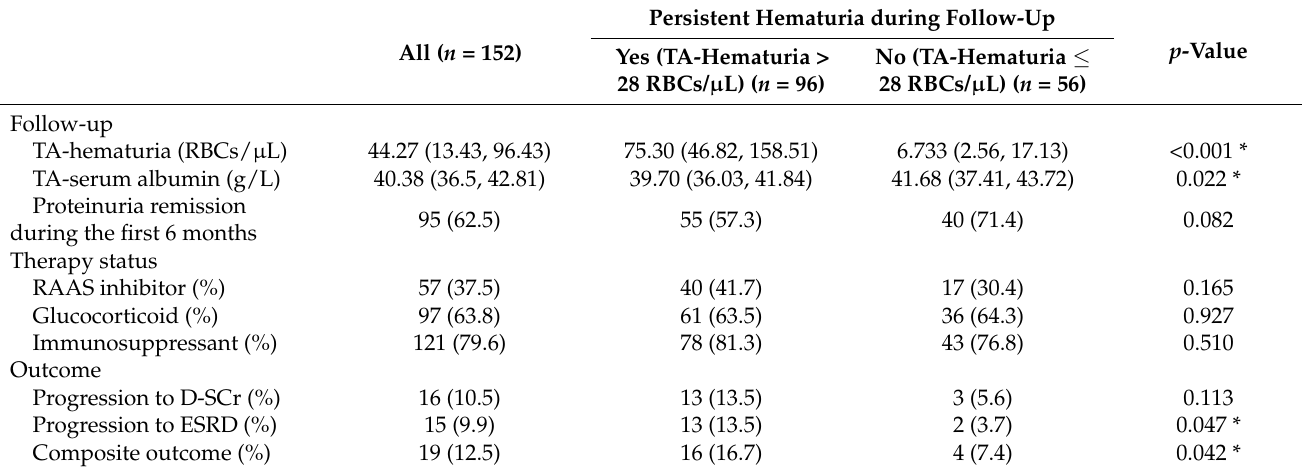
Table 2. Follow-up data and outcomes of participants with IgAN according to TA-hematuria.